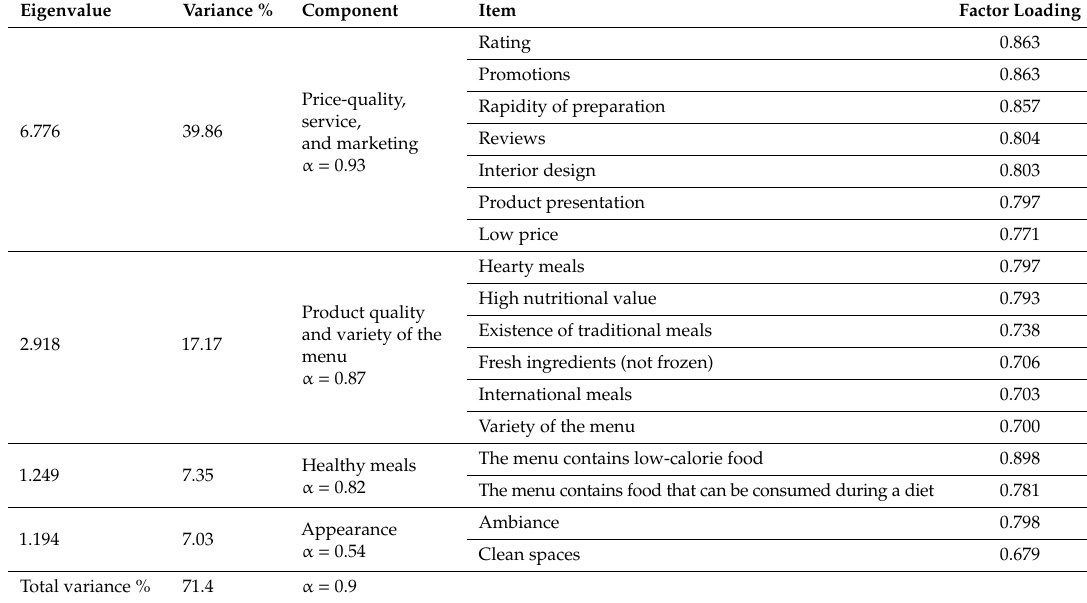
Table 3. Principal component analysis (PCA) of the factors influencing restaurant